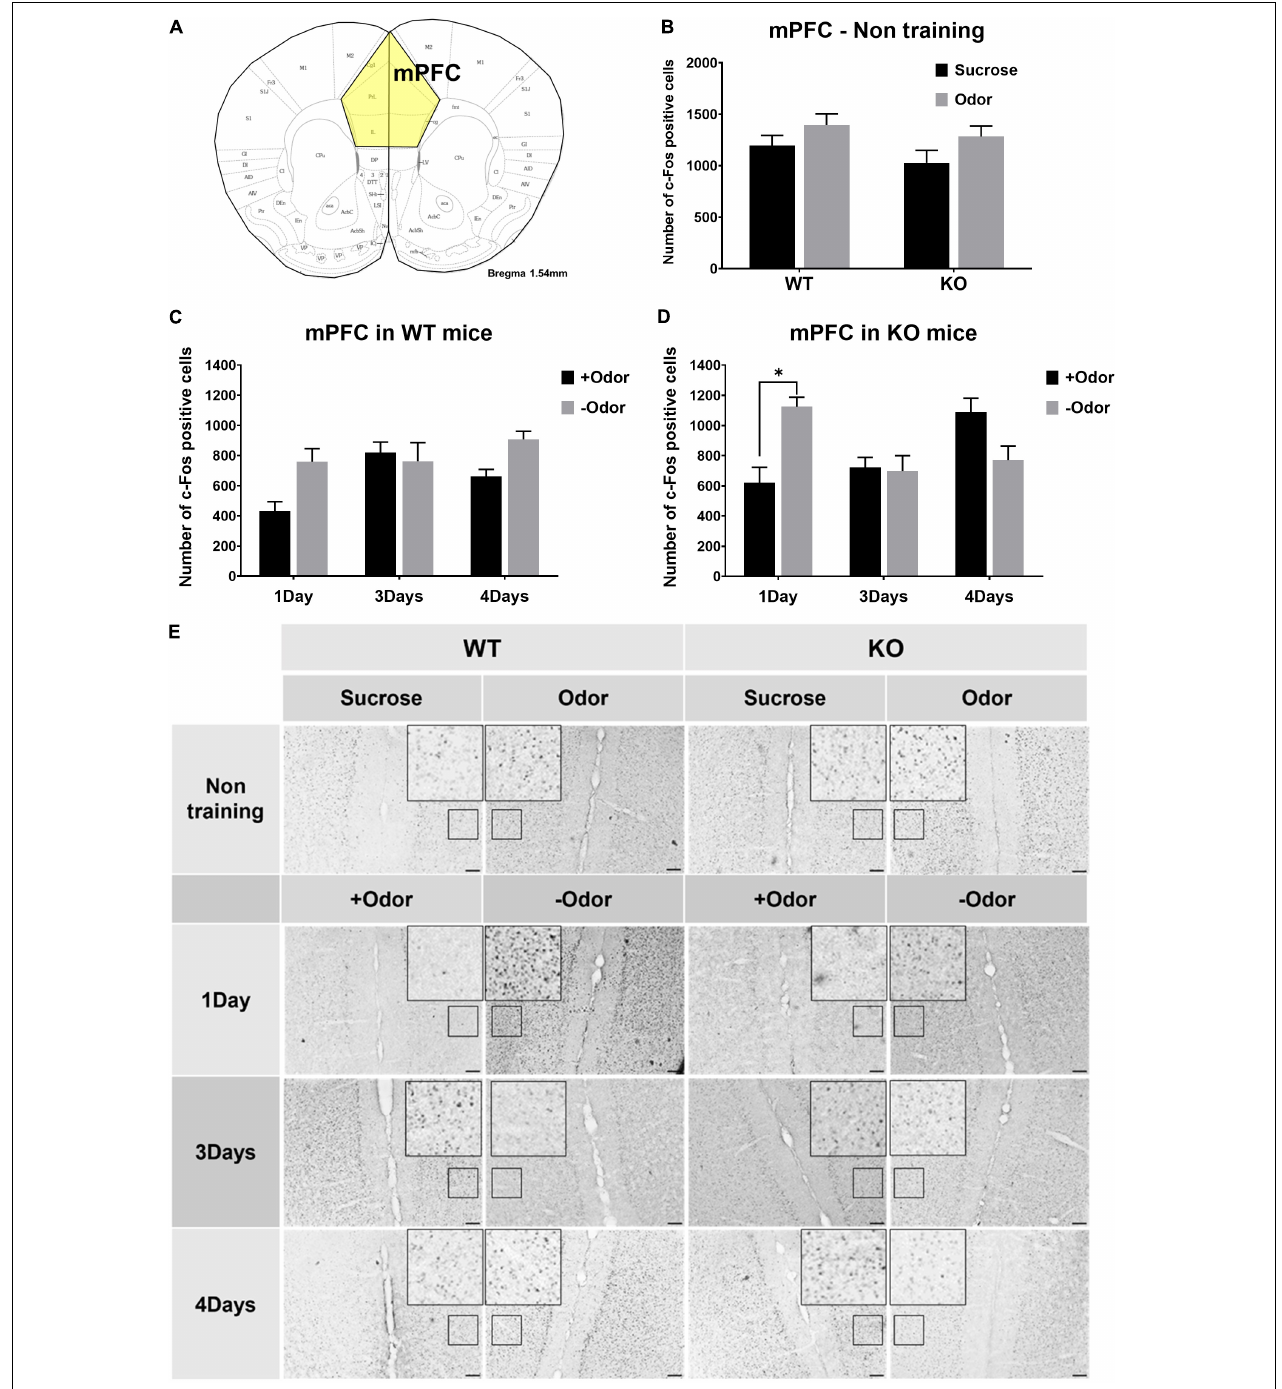
FIGURE 3 | Conditioned stimulus (CS)-evoked neural activation in the mPFC over the course of odor-sugar conditioning in wild-type (WT) and PLC β 1-knockout (KO) mice. (A) Schematic representation of the mPFC in mice. (B) Number of c-Fos-positive cells in the mPFC after the exposure to sucrose (black) or odor (gray) in non-training group of WT and KO mice. (C,D) Number of c-Fos-positive cells in the mPFC after the exposure to +Odor (black) or –Odor (gray) with 1Day, 3Days, or 4Days training condition in WT mice (C) and in KO mice (D) . (E) Representative images of c-Fos immunohistochemistry in the mPFC. Calibration bar is 100 µ m. Numbers of mice ( N ) and sections ( n ): (B) (mPFC - non training: WT Sucrose, N = 4, n = 5; WT Odor, N = 3, n = 6; KO Sucrose, N = 3, n = 6; KO Odor, N = 3, n = 6), (C) (WT mPFC: 1Day +Odor, N = 4, n = 8; 1Day –Odor, N = 3, n = 6; 3Days +Odor, N = 5, n = 10; 3Days –Odor, N = 3, n = 6; 4Days +Odor, N = 10, n = 14; 4Days –Odor, N = 9, n = 18), (D) (KO mPFC: 1Day +Odor, N = 3, n = 6; 1Day –Odor, N = 3, n = 6; 3Days +Odor, N = 3, n = 6; 3Days –Odor, N = 3, n = 6; 4Days +Odor, N = 6, n = 11; 4Days –Odor, N = 6, n = 9). All the values are mean ± SEM. ∗ p < 0.05.